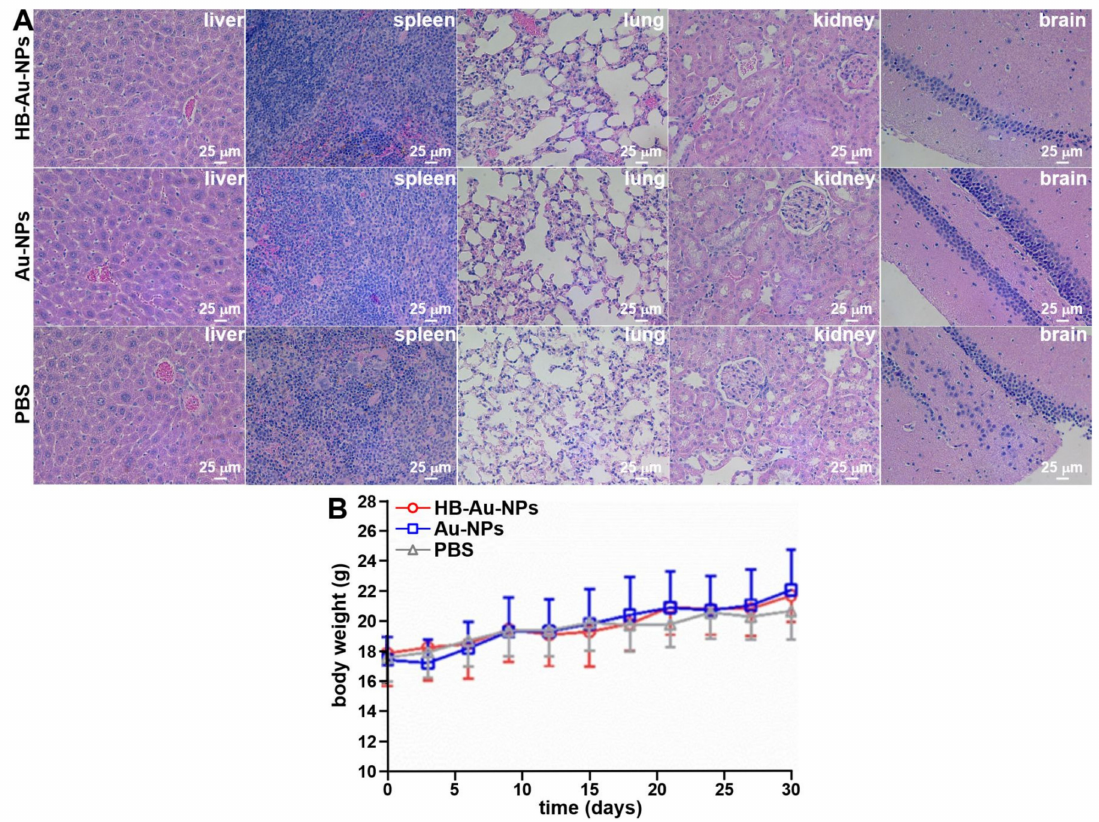
Figure 7. Animal necropsy. Histology (H&E) is shown for major organs, including liver, spleen, lung, kidney, and brain from the mice treated with ( A ) HB-Au-NPs, Au-NPs, and PBS at day 30 following intravenous administration. ( B ) The mean body weight from n = 4 animals shows no difference for mice injected with HB-Au-NPs, Au-NPs, and